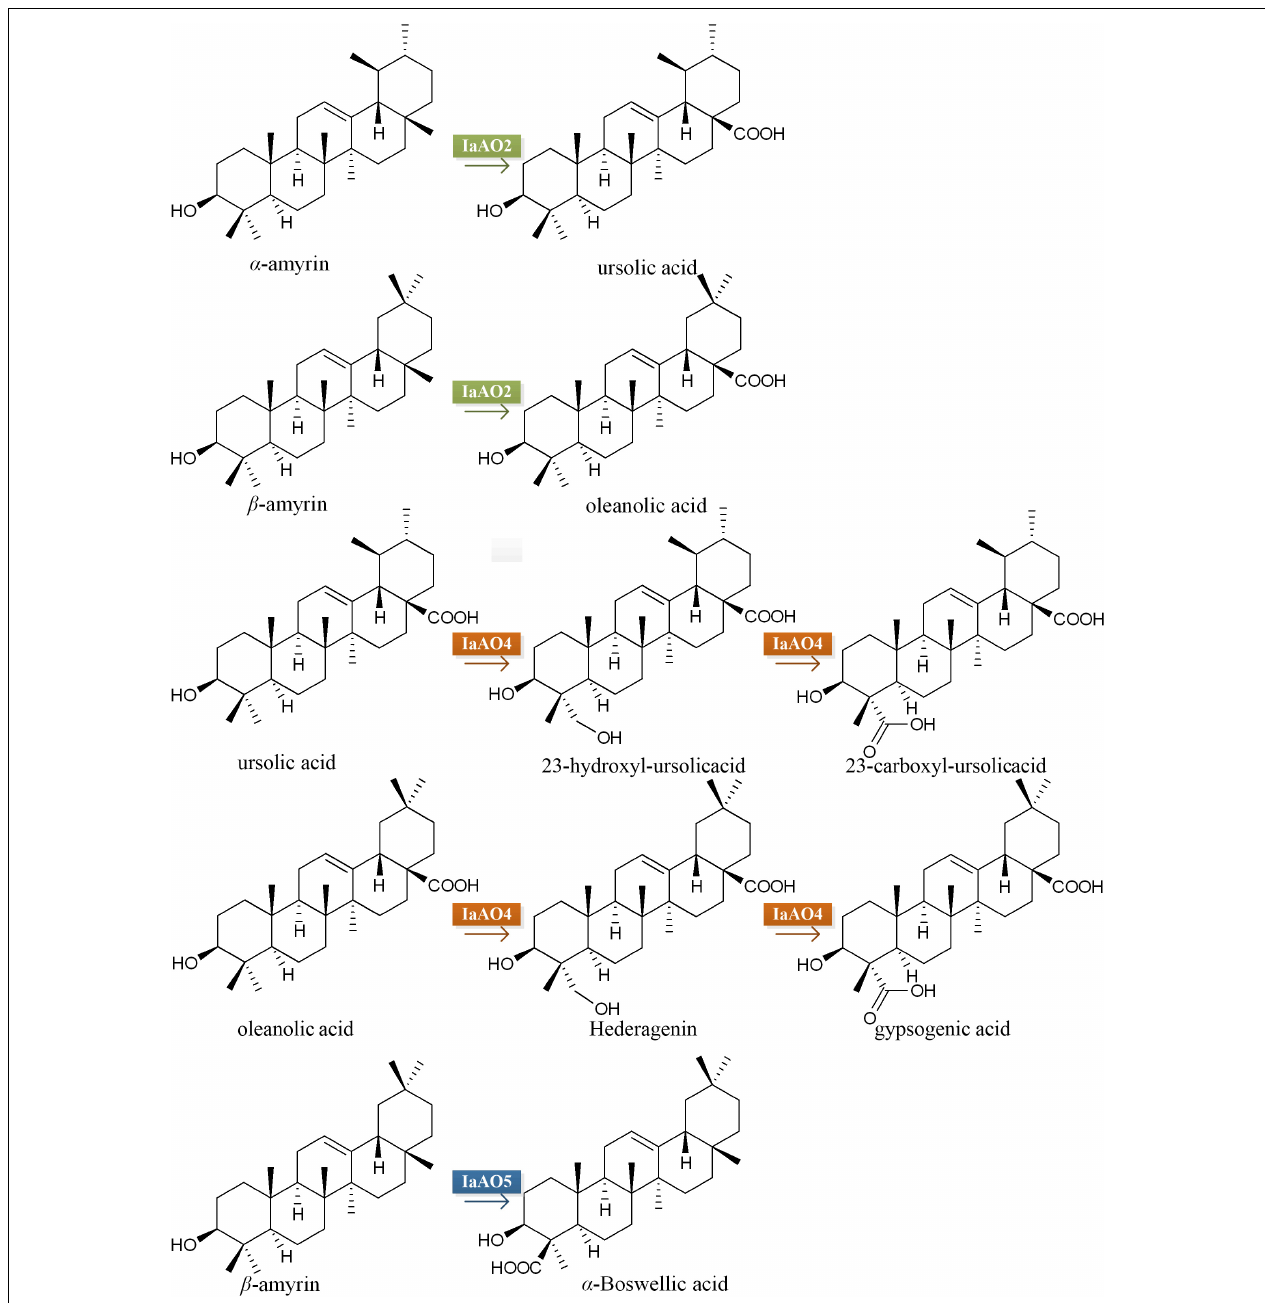
FIGURE 7 | Speculation on biosynthetic pathway of IaAO2, IaAO4, and IaAO5 in engineered yeast.